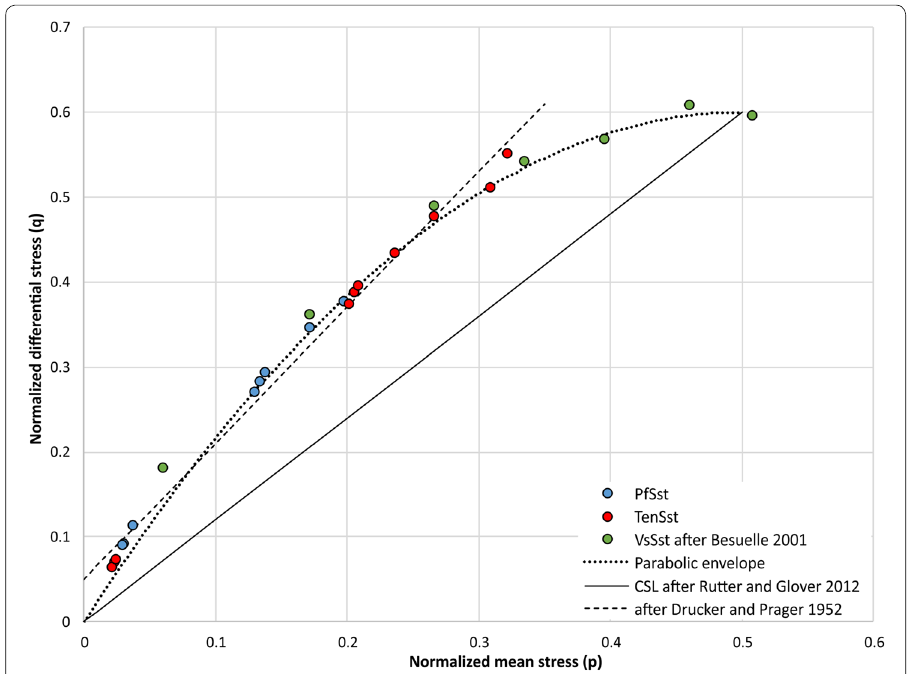
Fig. 10 Maximum differential stress of the different sandstones types PfSst (blue), TenSst (red) and VsSst (green). The results are compared with the criteria of Drucker and Prager (1952), Khan et al. (1991) and the concept of CSL (Rutter and Glover 2012) in normalized q – p